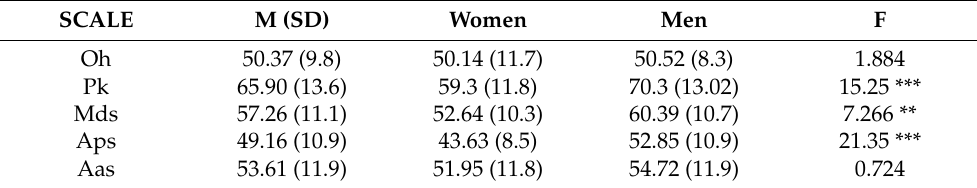
Table 4. Descriptive statistics of Minnesota Multiphasic Personality Inventory—2, MMPI-2 additional scales and gender